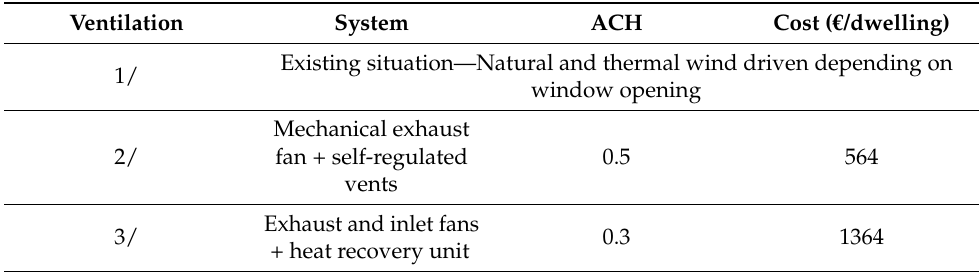
Table 3. Proposed renovation measures for the ventilation